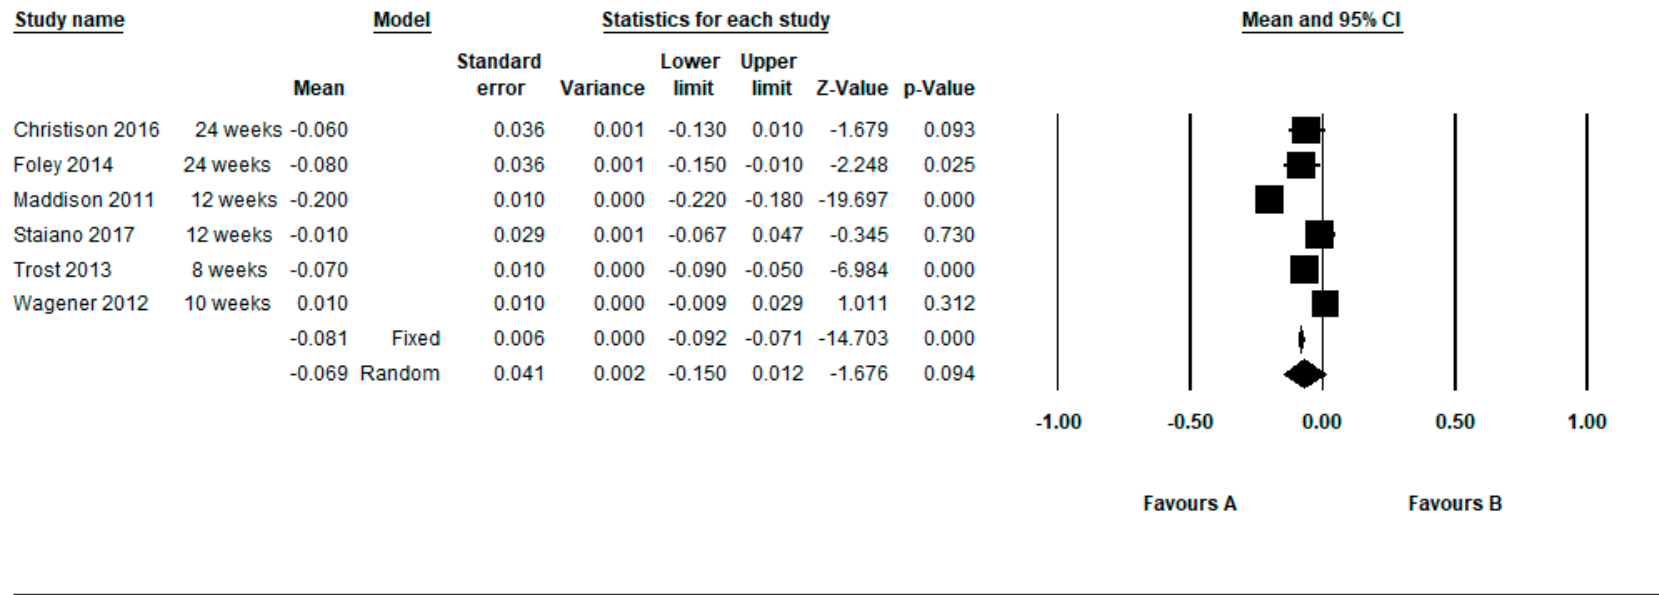
Figure 13. Pre-post difference of BMI between groups. Only BMI z-score in the shortest follow-up.